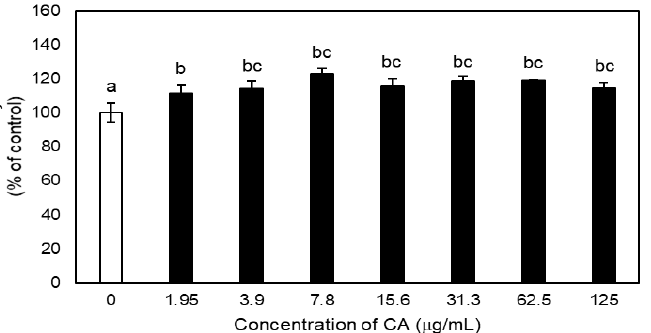
Figure 4. Effect of CA treatments on the cell viability of L929 cells depending on concentration measured by CCK-8 assay. Different lowercase letters indicate significant differences among groups detected by one-way ANOVA with Tukey’s multiple comparisons ( α ≤ 0.05).